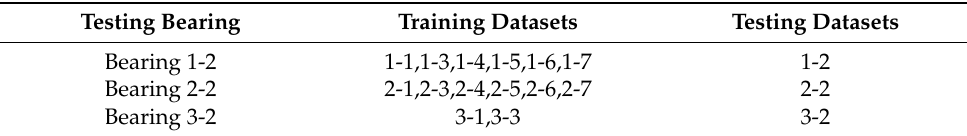
Table 2. The specific experimental arrangement of 1-2,2-2, and 3-2 in Test 1.